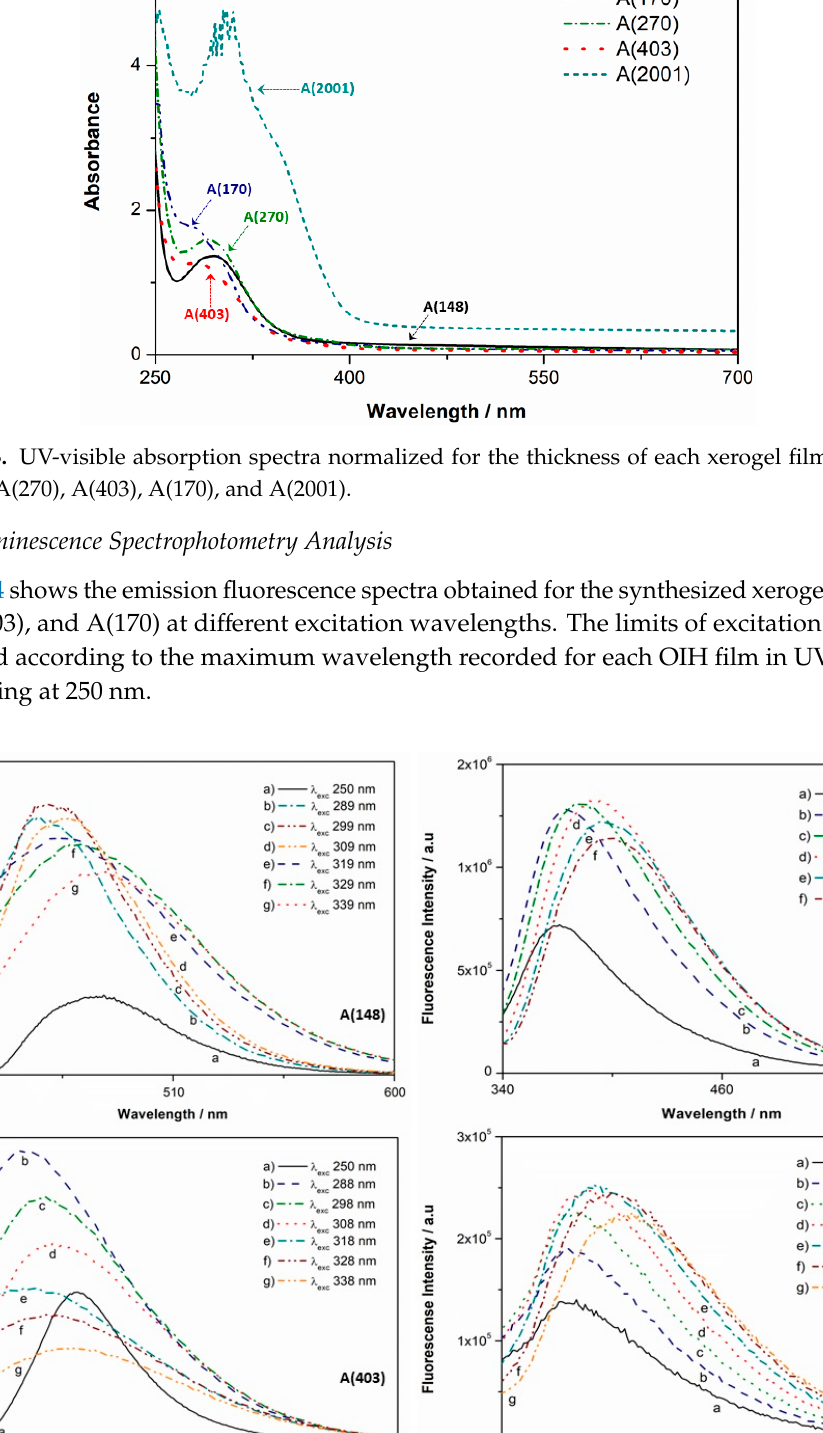
Figure 3. UV-visible absorption spectra normalized for the thickness of each xerogel film, namely A(148), A(270), A(403), A(170), and A(2001). The highest absorbance peaks were found in the UV region between 250 and 300 nm (Figure 3).